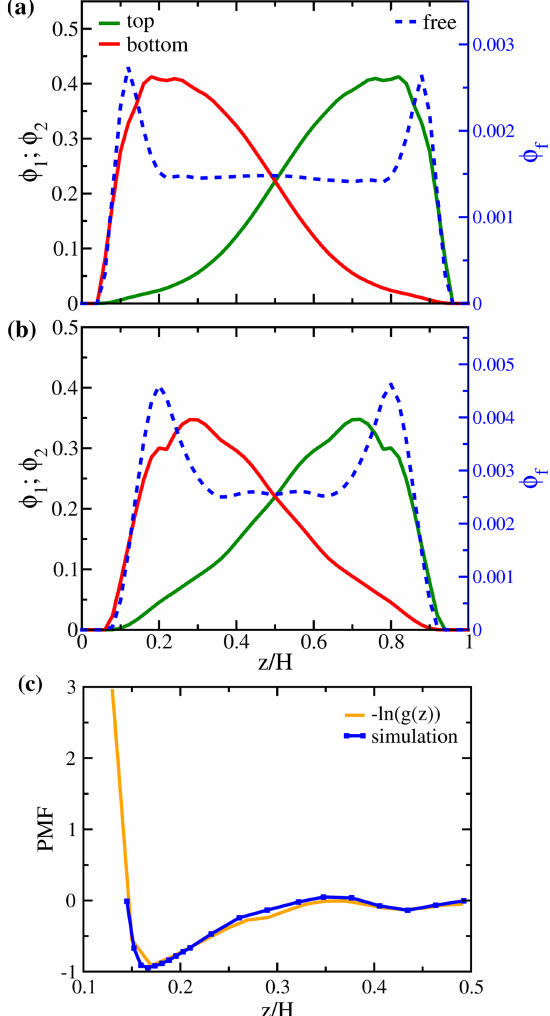
Figure 8. Local volume fraction distributions of polymer beads (solid lines; left axis) and free particles (dashed line; right axis) for ( a ) AA+400 and ( b ) MM+400. ( c ) Comparison of the potential of mean force calculated from g ( z ) and directly from simulation (see text in Section 2) for system MM+400. The energy at z / H = 0.5 is set to zero as a